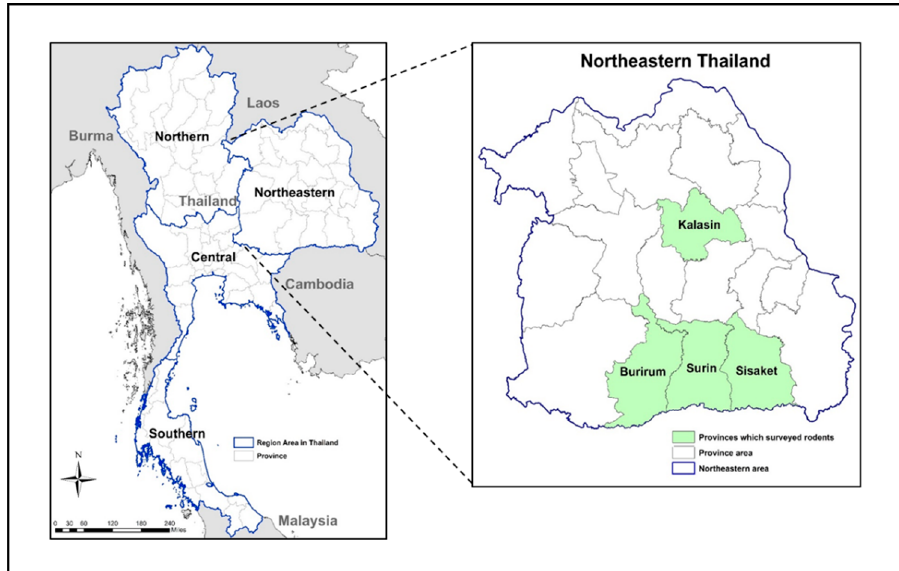
Figure 1. Map of Thailand showing the provincial locations for pathogenic Leptospira surveillance in rodent populations between 2011 and 2012. Four provinces (Burirum, Kalasin, Sisaket, and Surin) located in the northeast region of Thailand.